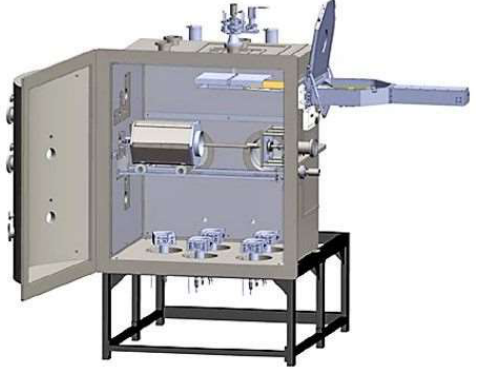
Figure 1. TORR 5X300EB-45kW electron flux deposition system.